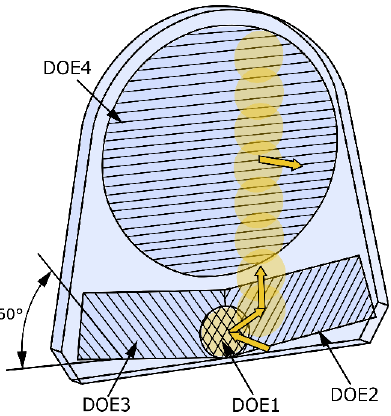
Figure 6. Propagation of radiation inside a waveguide with thermal compensation.